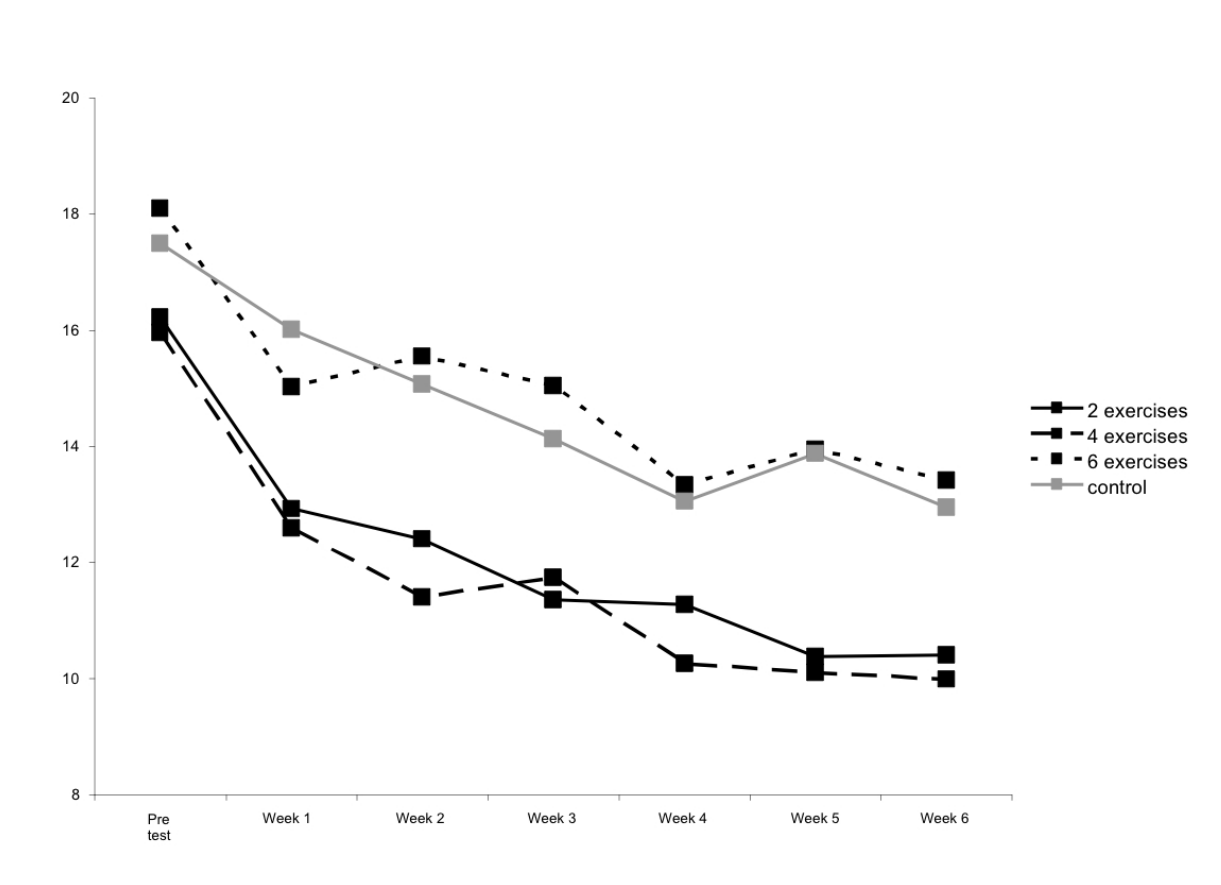
Figure 2. Mean CES-D scores by